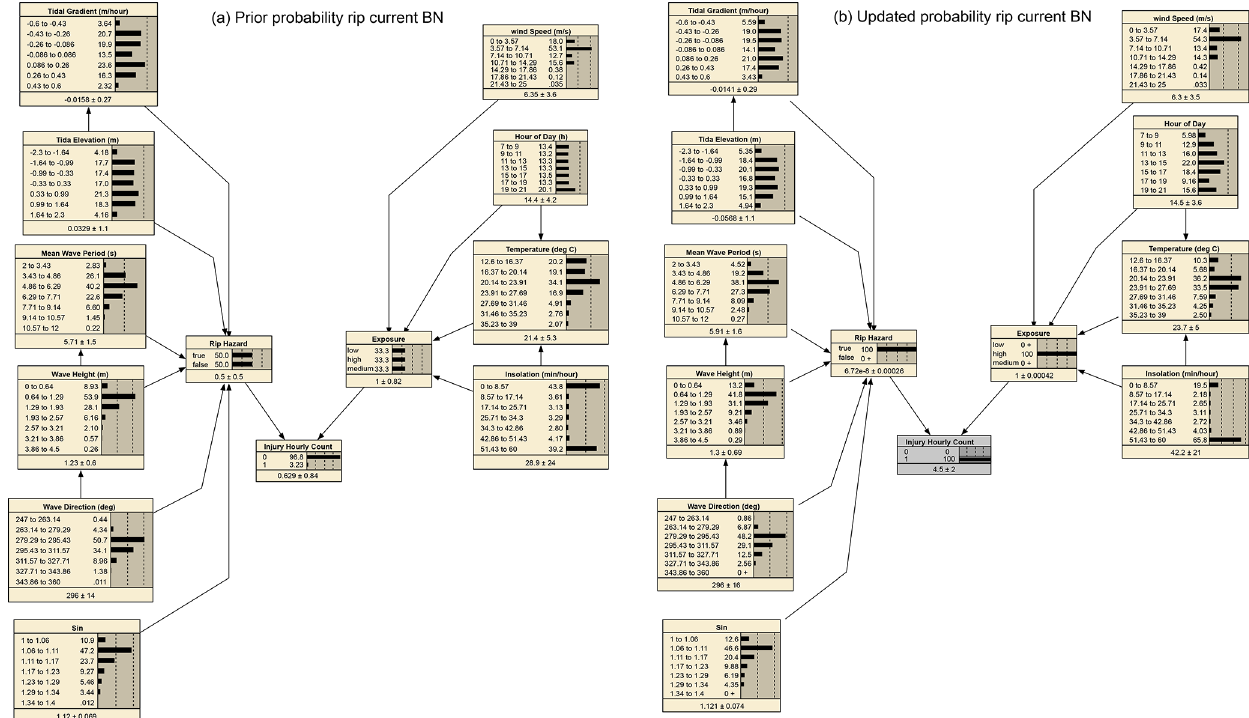
Figure 11. (a) Prior probability distribution of the rip-current BN; (b) updated probability distribution of the rip-current BN when the probability of an injury occurring was set to